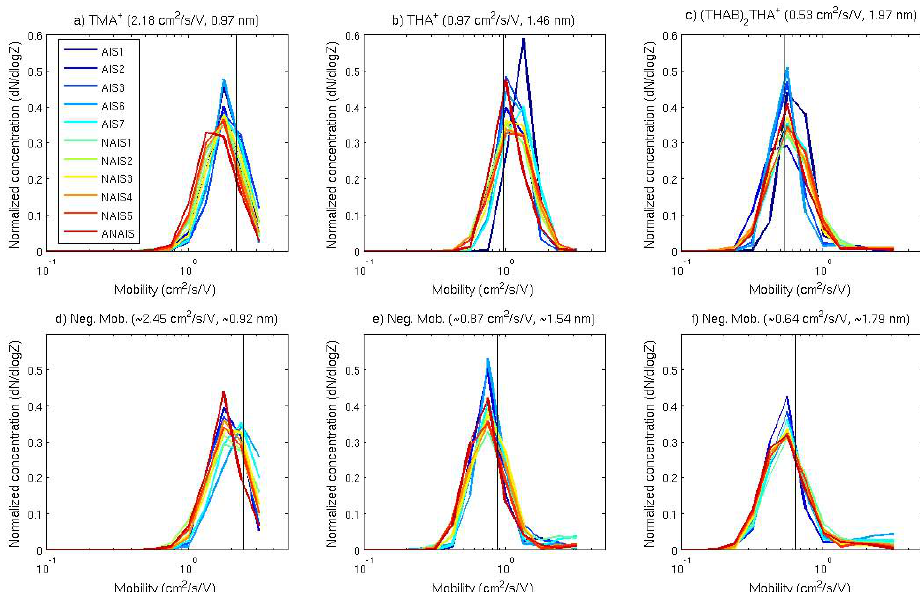
Fig. 3. Examples of mobility standards measurements. Panels (a) , (b) and (c) show the response of the ion spectrometers (normalized mobility distribution) for 3 positively charged mobility standards, and panels (d) , (e) and (f) for 3 negative mobilities. The black vertical lines represent the mobility that was selected through the HDMA. The mobility and size of the standards are above each plot. TMAI is tetra-methyl ammonium iodide and THAB is tetra-heptyl ammonium